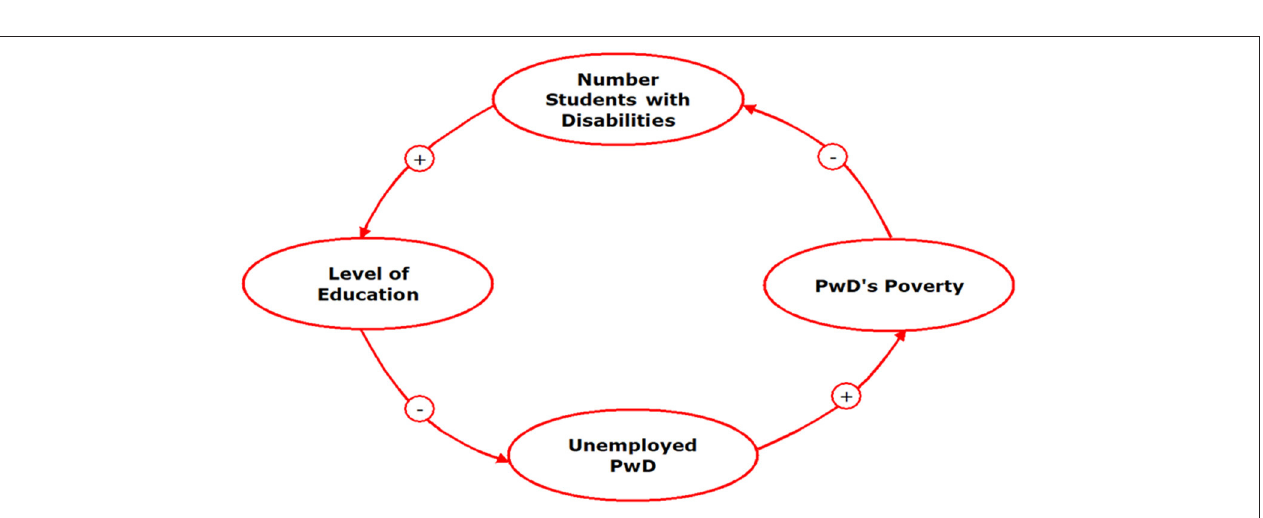
FIGURE 5 | Loop 3: poverty → number of PwD students → education level → PwD unemployment → poverty. The “ + ” symbol indicates unidirectional causality, and the “ − ” symbol in the arrow represents the opposite directions of